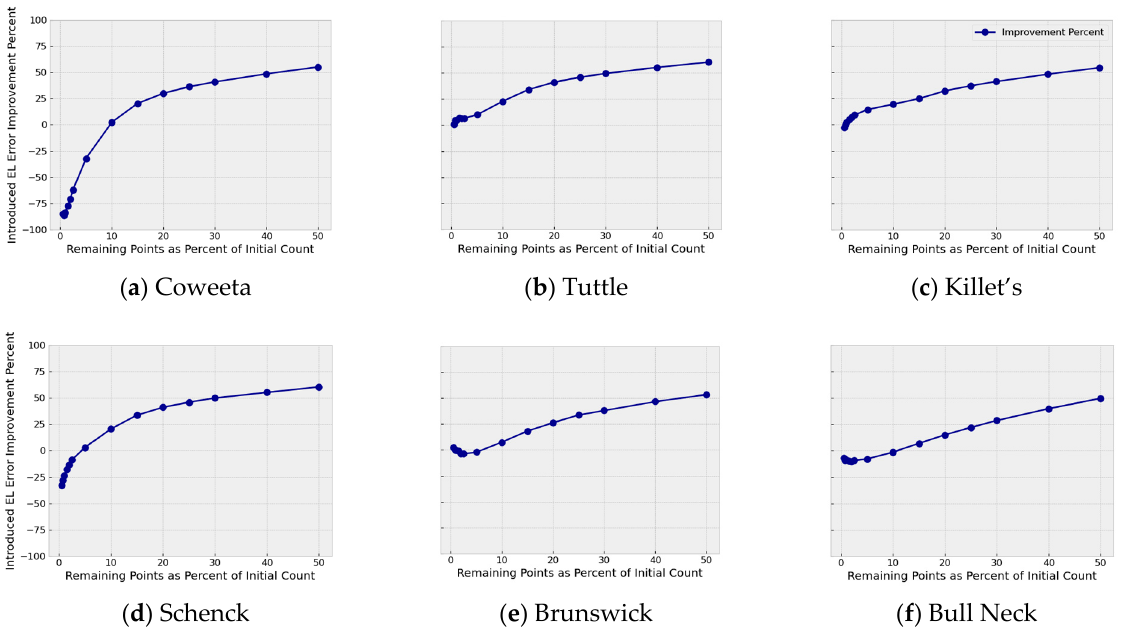
Figure 11. Improvement percentages versus decimation percentages for Curvature Weighted Deci- mation versus Random Decimation for all six lidar study areas.